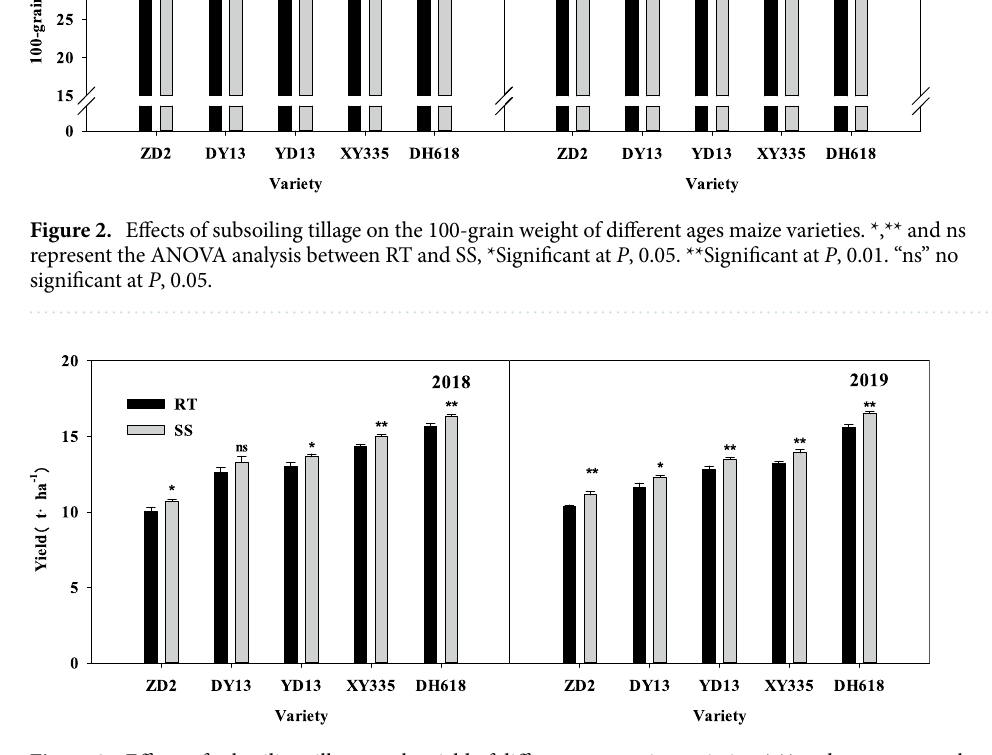
Figure 3. Effects of subsoiling tillage on the yield of different ages maize varieties. *,** and ns represent the ANOVA analysis between RT and SS, *Significant at P , 0.05. **Significant at P , 0.01. ns no significant at P ,